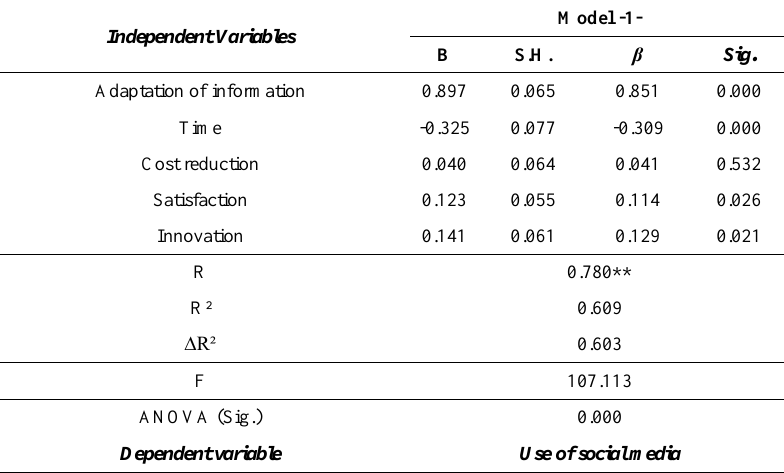
Table 9. Analyzes of